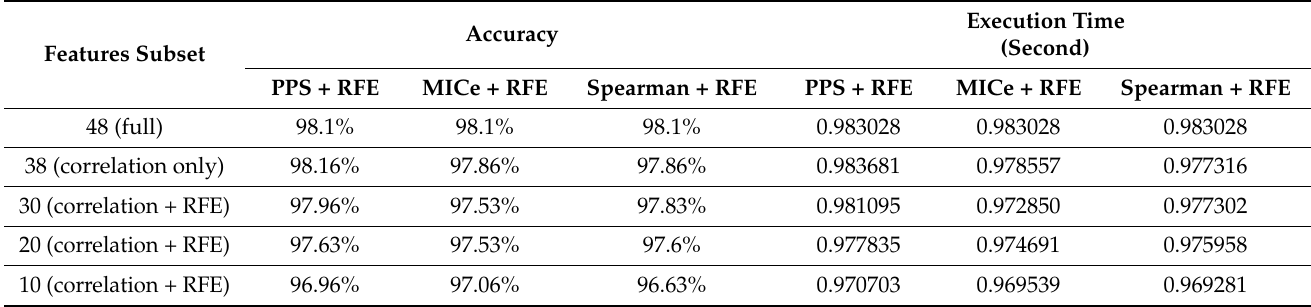
Table 15. Feature subset accuracy and execution time on Dataset 1.